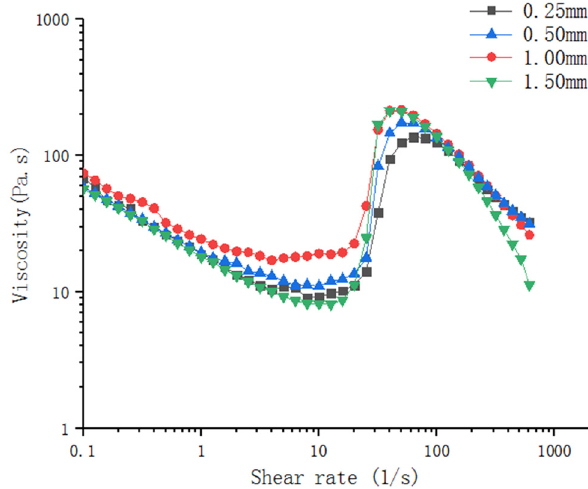
Figure 5: Steady - state rheological properties of 0.1% PVP samples with di ff erent plate spacing.